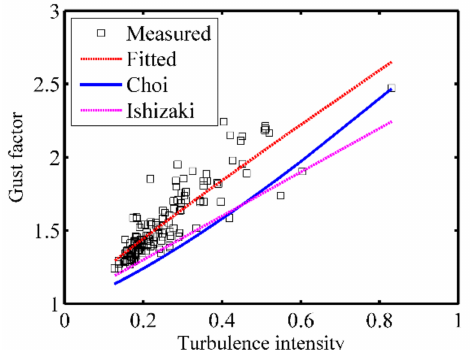
Figure 19. Relationship between the turbulence intensity and the gust factor.